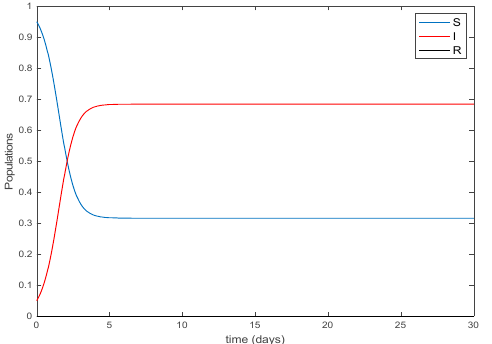
Figure 1. Evolution of the populations for β = 2.5 and γ = 0.79 days − 1 in the absence of external control actions, leading to a persistent infection.